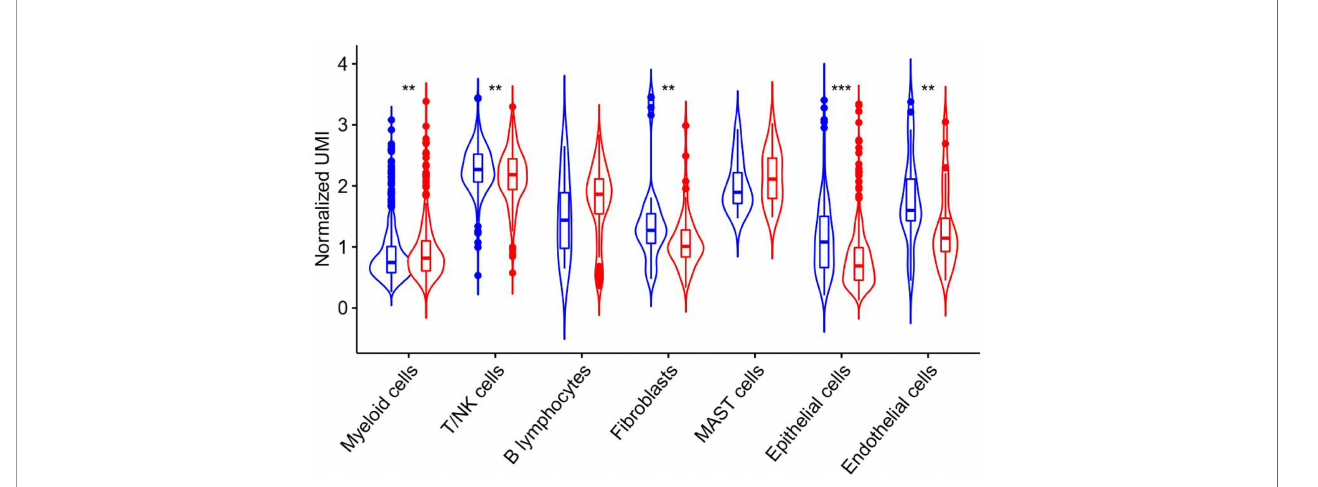
FIGURE 5 | ATR expression in unique molecular identi fi ers in the indicated cell types from single-cell RNA-Seq data derived from human LUAD specimen. Blue represents the expression of ATR in each component of normal tissue, and red represents the expression of ATR in each component of tumor